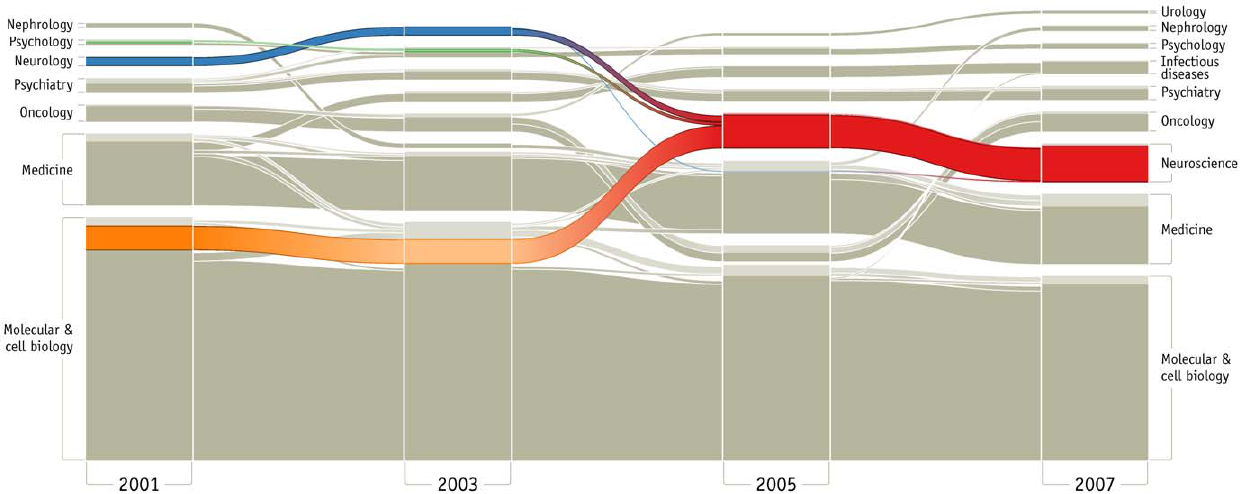
Figure 3. Mapping change in science. This set of scientific fields show the major shifts in the last decade of science. Each significance clustering for the citation networks in years 2001, 2003, 2005, and 2007 occupies a column in the diagram and is horizontally connected to preceding and succeeding significance clusterings by stream fields. Each block in a column represents a field and the height of the block reflects citation flow through the field. The fields are ordered from bottom to top by their size with mutually nonsignificant fields placed together and separated by half the standard spacing. We use a darker color to indicate the significant subset of each cluster. All journals that are clustered in the field of neuroscience in year 2007 are colored to highlight the fusion and formation of neuroscience.